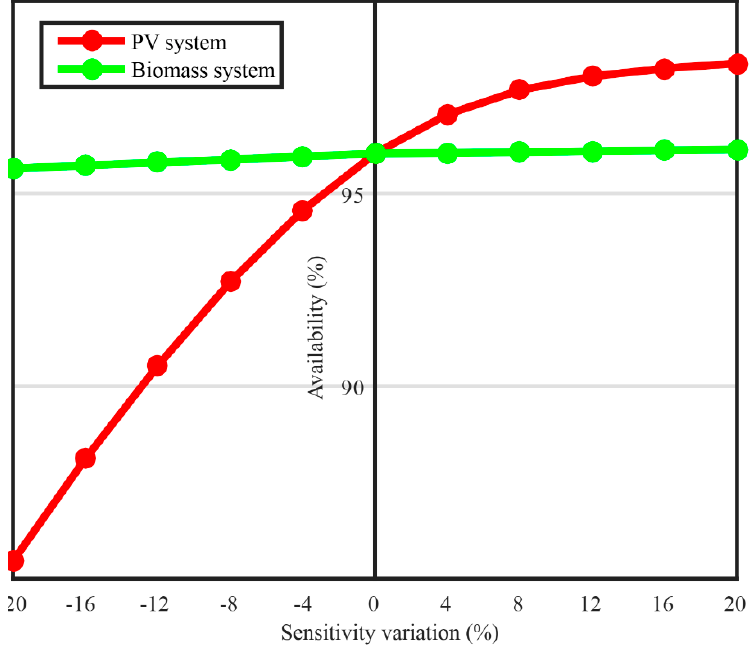
Figure 14. Sensitivity analysis application for the Availability index.